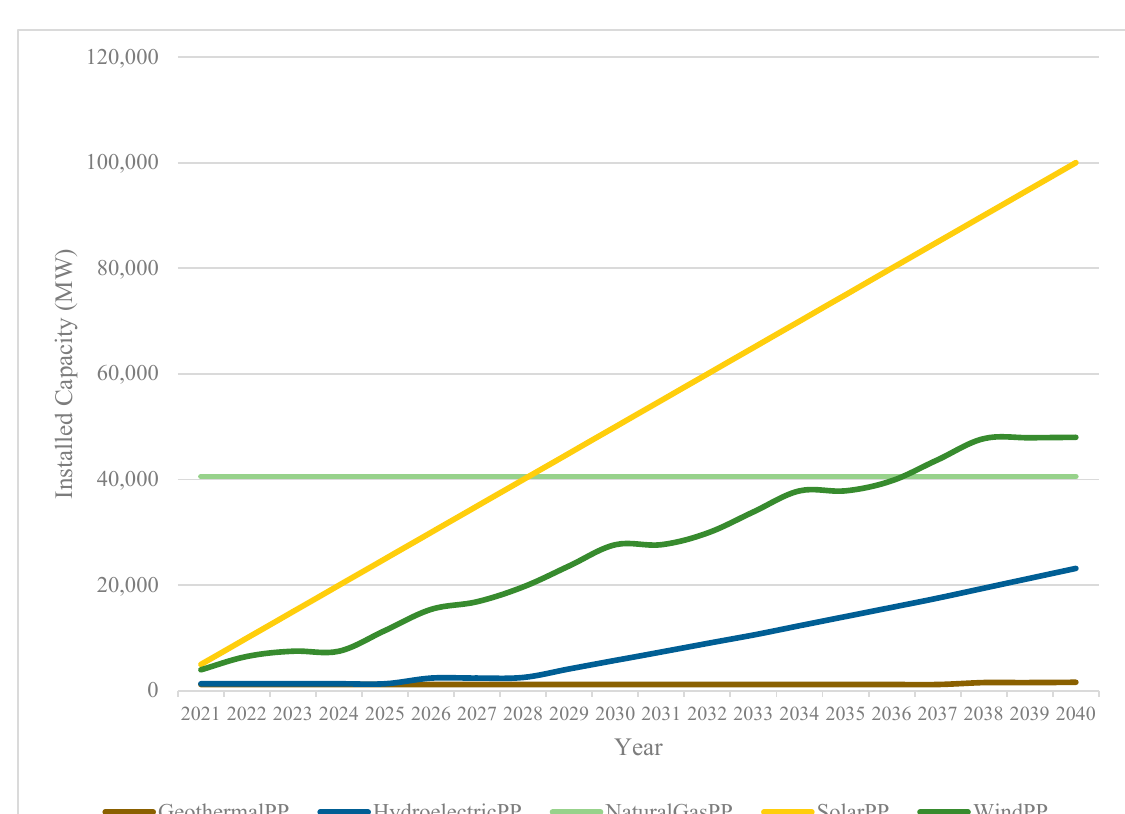
Figure 6. Installed capacities for the second scenario in the 2021–2030 horizon.